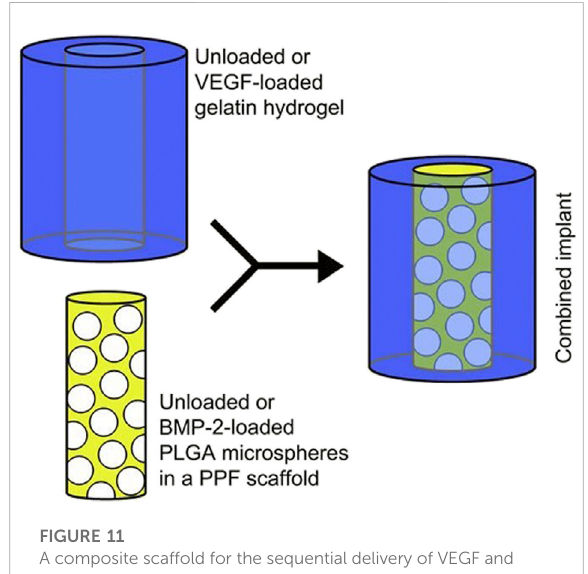
FIGURE 11 A composite scaffold for the sequential delivery of VEGF and BMP-2 is illustrated. (Reproduced with permission from Ref (Kempenetal.,2009).Copyright ©